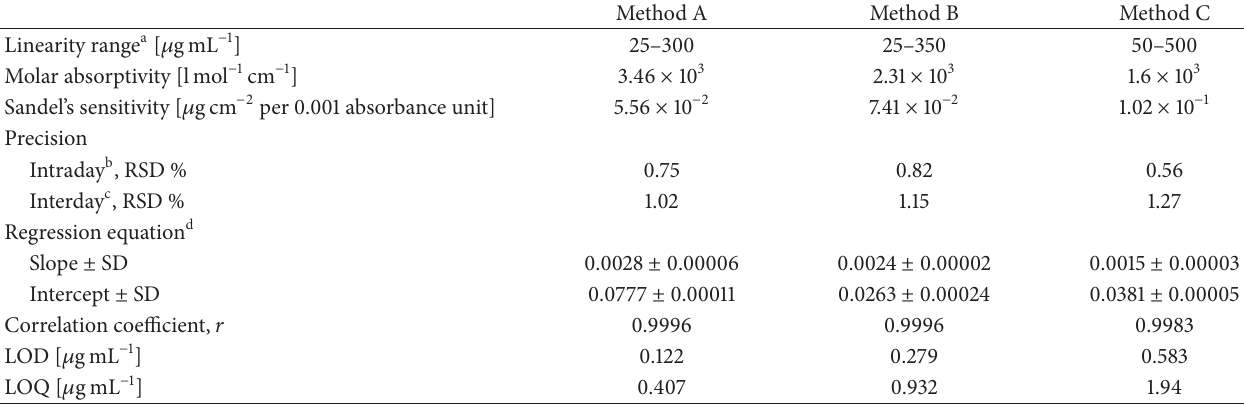
Table 1: Results of analytical parameters for proposed methods.